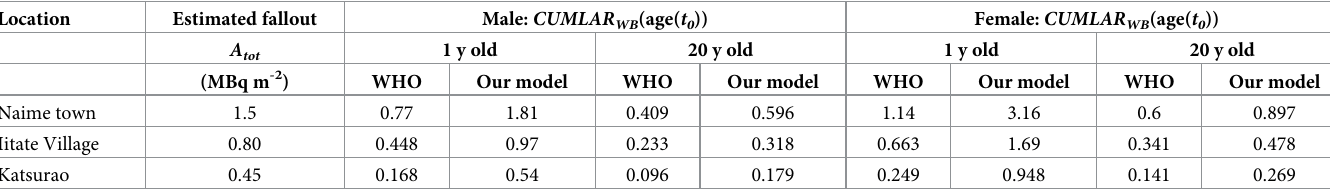
Table 9. Lifetime attributable risk, CUMLAR ( age(t 0 ) ) (LAR � 10 − 2 ), the first year upon fallout in three different Japanese settlements: comparison between WHO estimates [9] and our model estimates. Lifetime attributable risk refers to sum over both solid cancers and leukaemia. Location Estimated